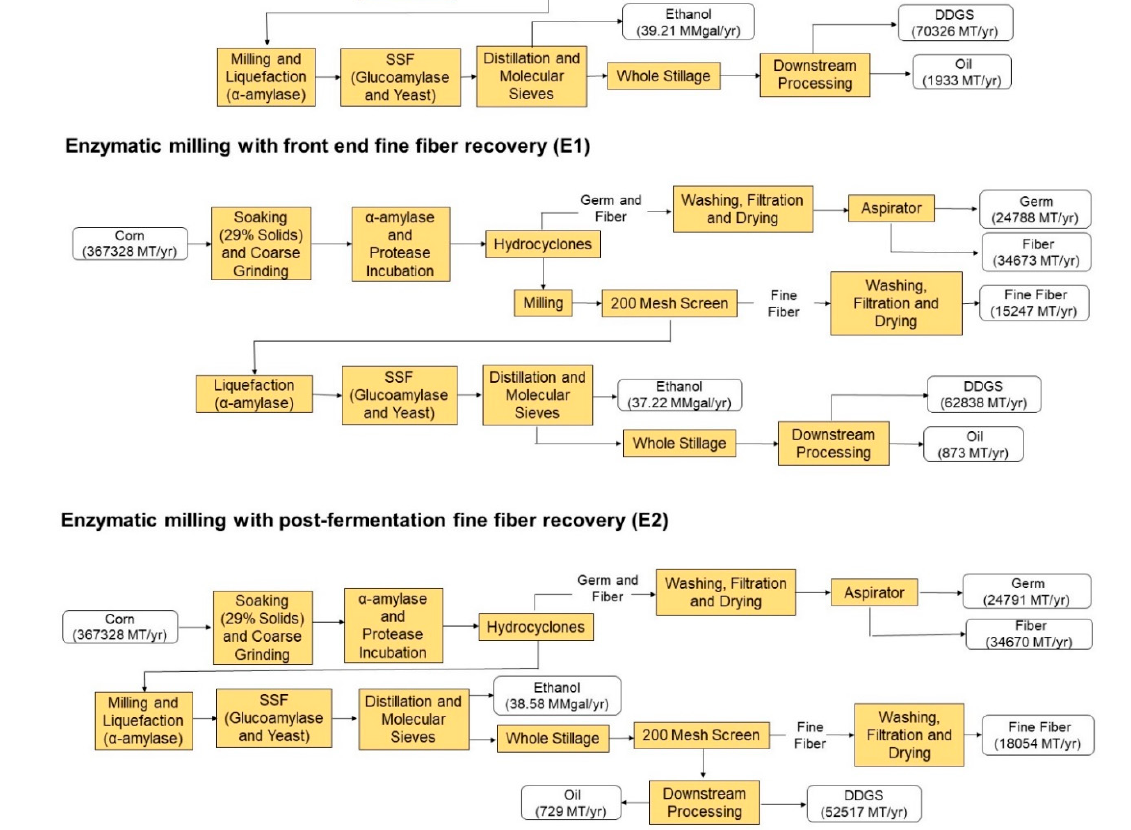
Figure 1. Schematic for conventional dry grind process and wet fractionation processes.